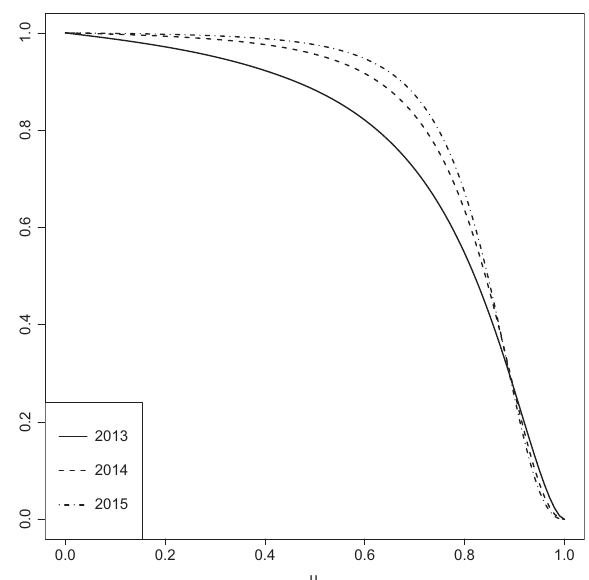
^ d ^ d ¼ B (see Eq. (15)).